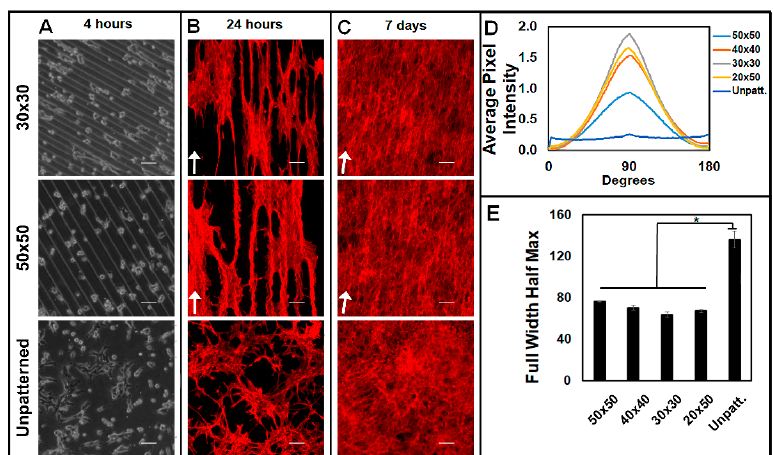
Figure 3. Cell alignment on substrates over 7 days. Cell morphology is shown ( A ) after 4 h by phase contrast and ( B ) 24 h and ( C ) 7 days by visualization with rhodamine phalloidin. ( A – C ) Scale bars = 100 µ m. ( D ) Radial sum curves for alignment of confluent cell cultures with 10 µ m heights after 7 days. ( E ) Full width half maximum values obtained from radial sum curves n = 5 unique images per substrate condition. Data are presented as mean ± SE, where * p ≤ 0.05.